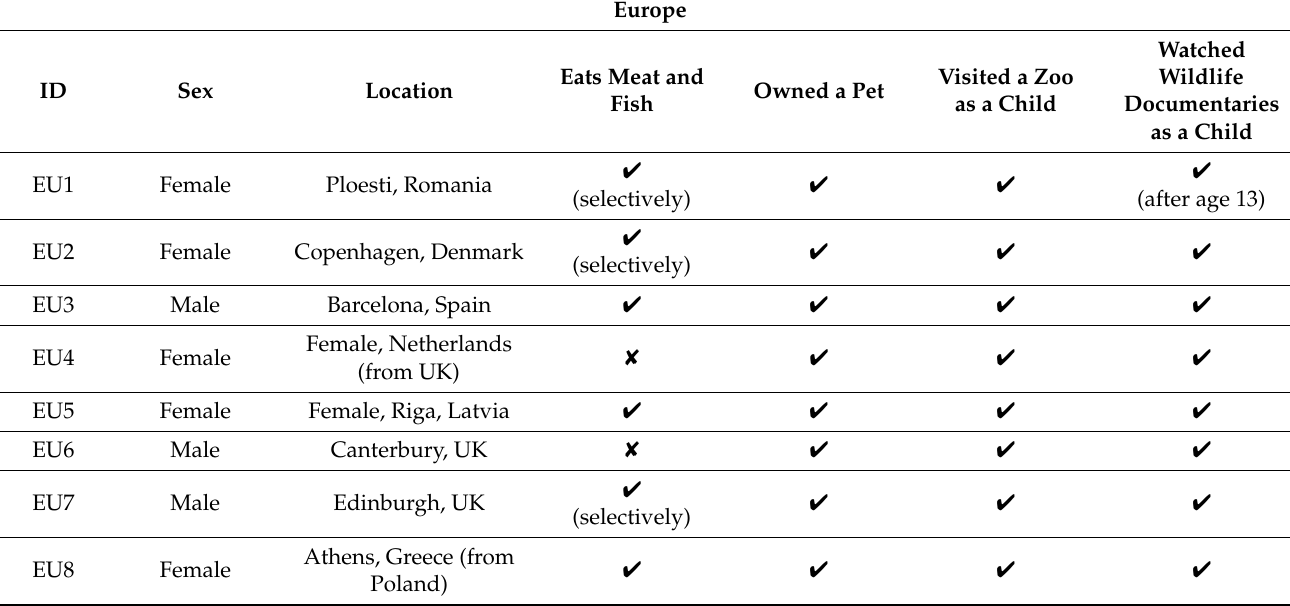
Table 3. Anonymised demographic characteristics of interviewees in Europe. EU = Europe), numbers 1–8 in chronological order of interview. (cid:52) represents an affirmative response to the survey item whilst (cid:56) represents a negative